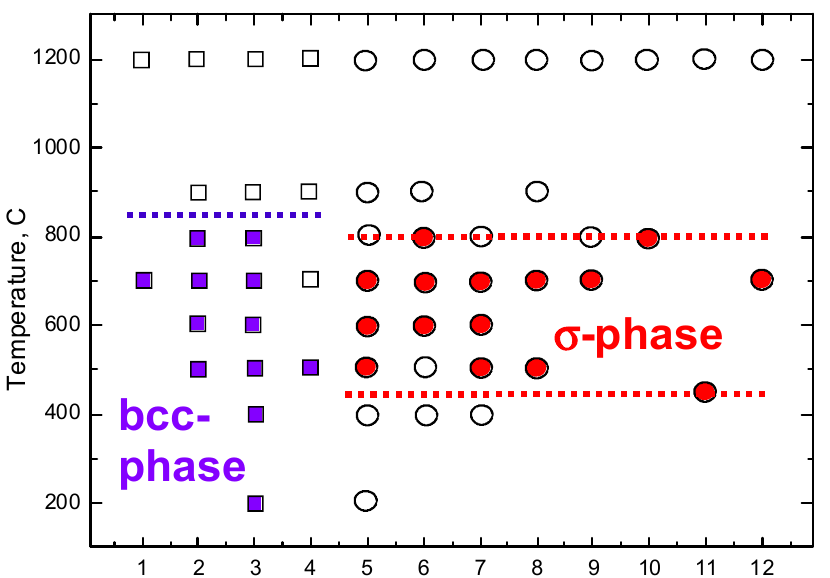
Figure 4. The diagram shows the presence (filled symbols) or absence (open symbols) for bcc-phase (squares) and σ -phase (circles) at various temperatures. The diagram is constructed using the data of Refs. [5,18–24]. The numbers on the horizontal axis denote the literature source for the data: 1 [18], 2 [19], 3 [20], 4 [5], 5 [20], 6 [19], 7 [21], 8 [5], 9 [18], 10 [22], 11 [23], 12 [24].